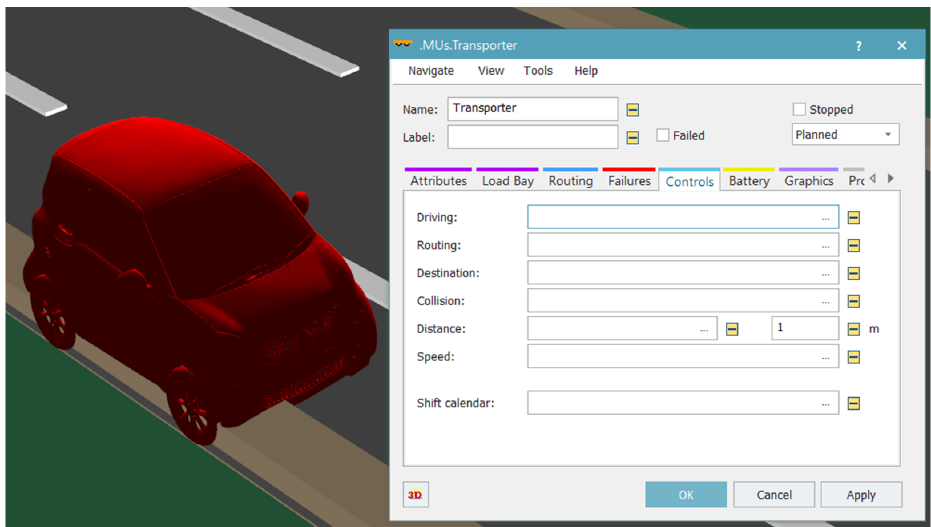
Figure 12. Mus.Transporter attribute defining